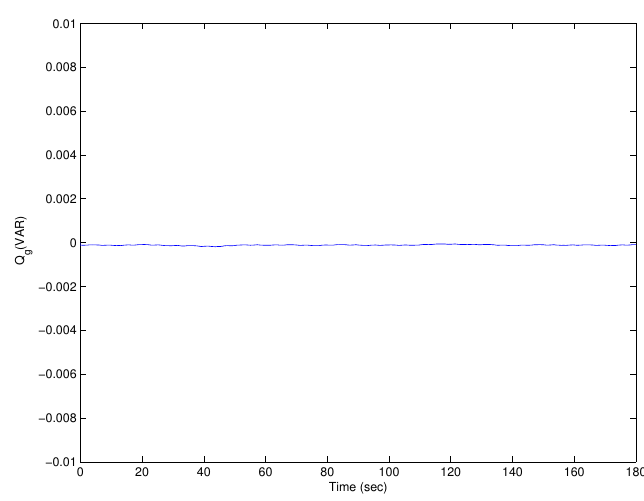
Figure 17. The output reactive power of the grid Q g versus